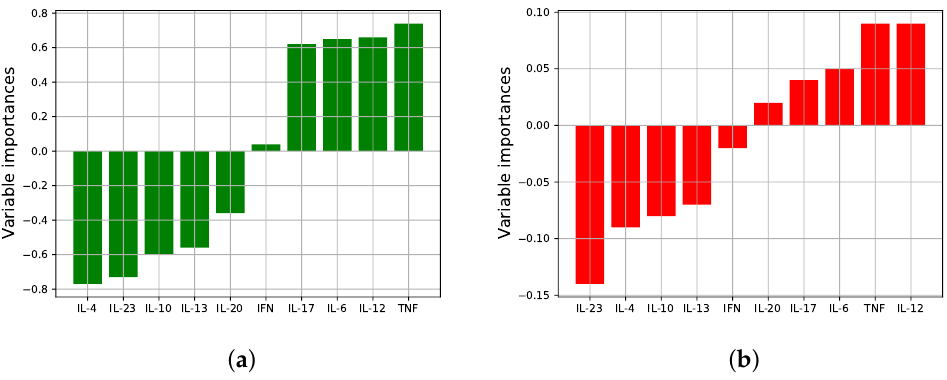
Figure 2. Variable importances (signed): ( a ) Comparing N and L group centroids (mean values of each variable); and ( b ) using regression coefficients from the PLSR model. The two methods largely agree in terms of which cytokines are most important and in whether up/down